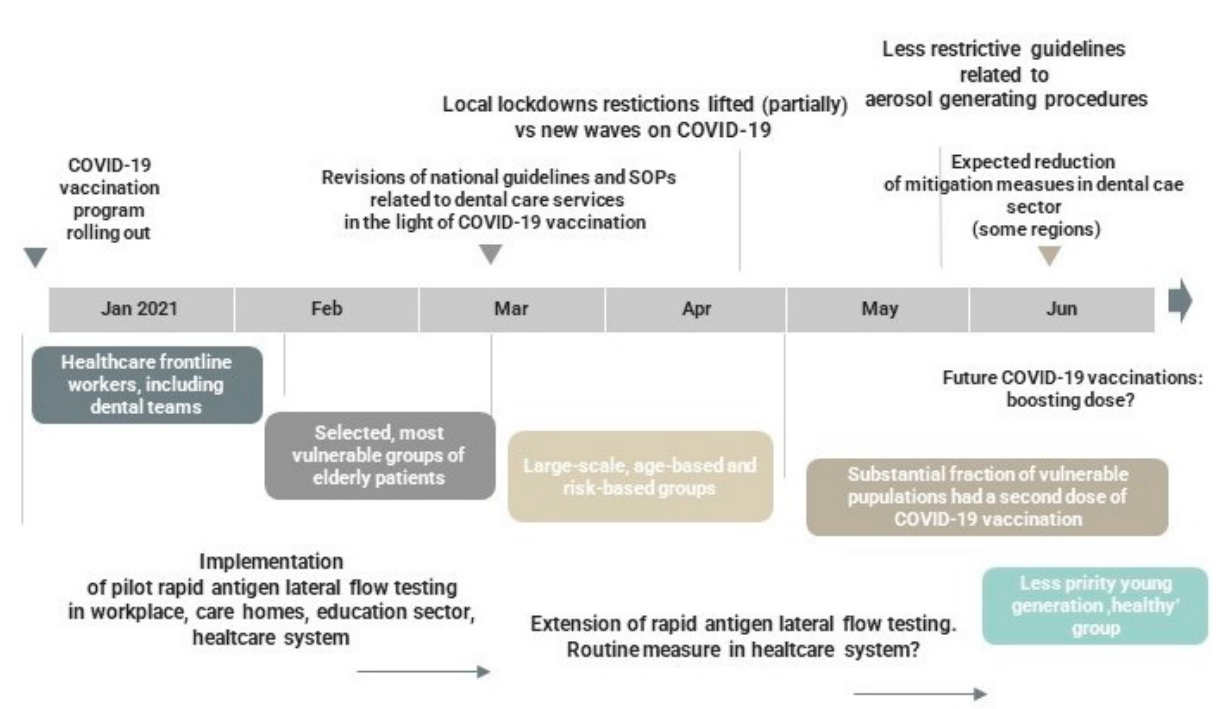
Figure 2. The predicted timescale of staged de-escalation and reinstallation of dental care services in 2021. Sequelae determined by COVID-19 mass vaccination.